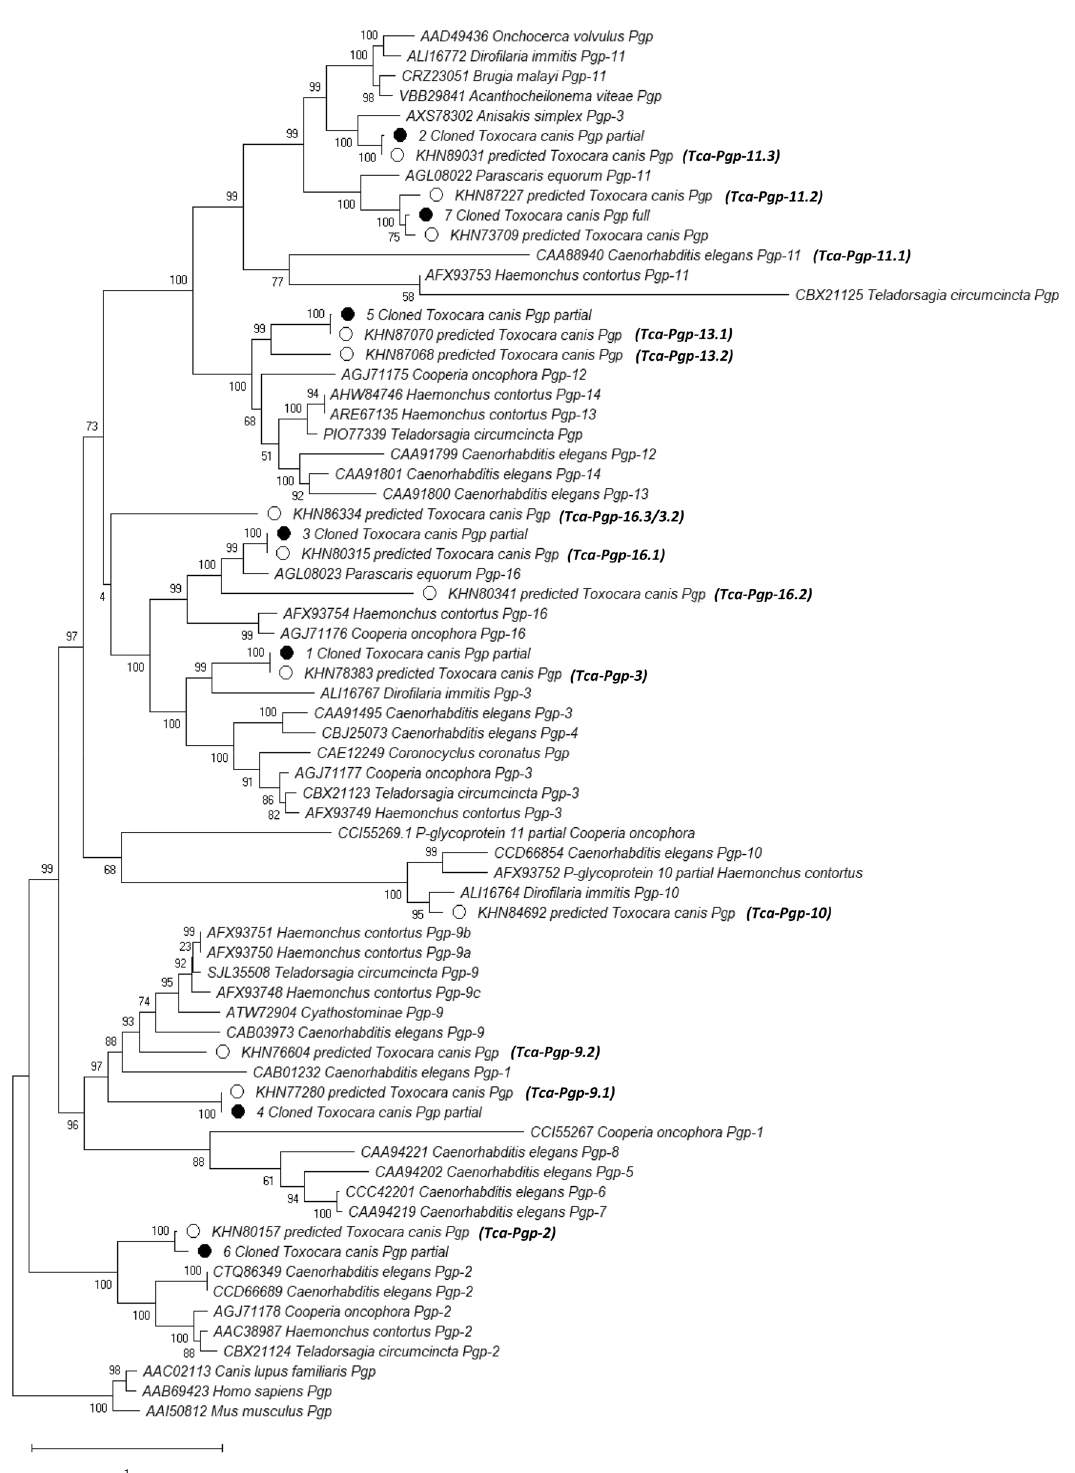
Figure 4. Maximum likelihood phylogenetic tree of conceptually translated P-gp genes. Pgp genes predicted in the genome (o) and cloned ( • ) are highlighted along with assigned names for T. canis P-gp